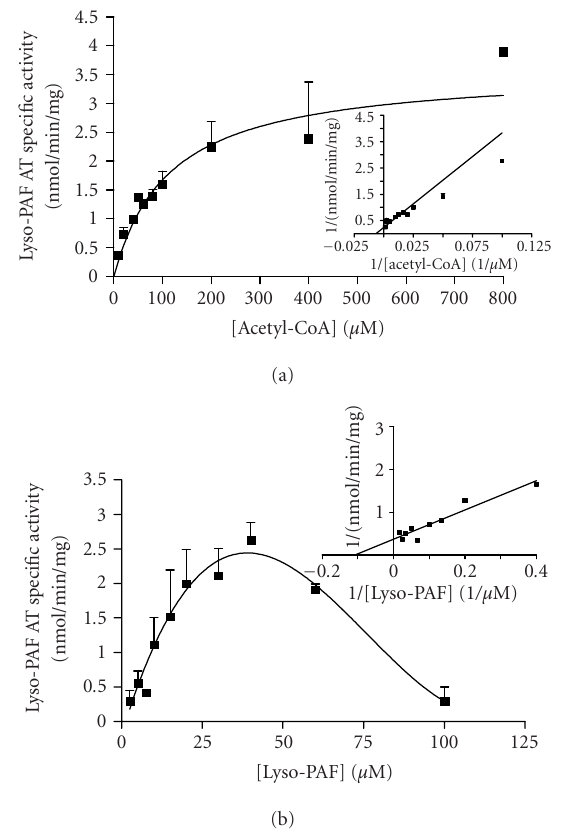
Figure 4. E ff ect of substrate concentration on lyso-PAF AT ac- tivity: (a) activity of lyso-PAF AT as a function of acetyl-CoA at fixed concentration of lyso-PAF (20 µ M); (b) activity of lyso-PAF AT as a function of lyso-PAF at fixed concentration of acetyl- CoA (200 µ M). Experiments were performed at total membrane fractions using 0 . 23 mg/mL protein in optimum conditions. Re- sults represent the average ± SD from four independent deter- minations using di ff erent enzyme preparations performing du- plicate samples.